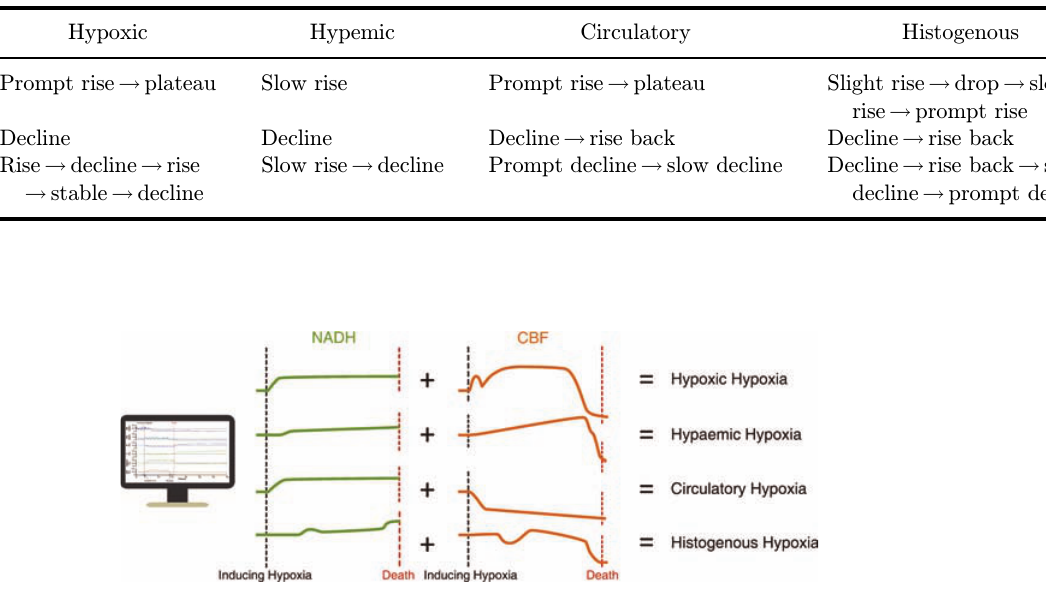
Table 2. Temporal change of NADH, re°ectance and CBF under di®erent hypoxia conditions during the time course from inducing hypoxia to